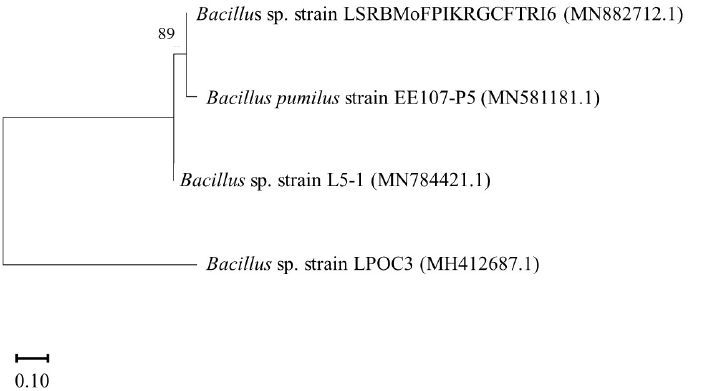
Figure 5. Relationship between all identified four isolates based on the phylogenetic analysis using the Neighbor-Joining method conducted in MEGA11.